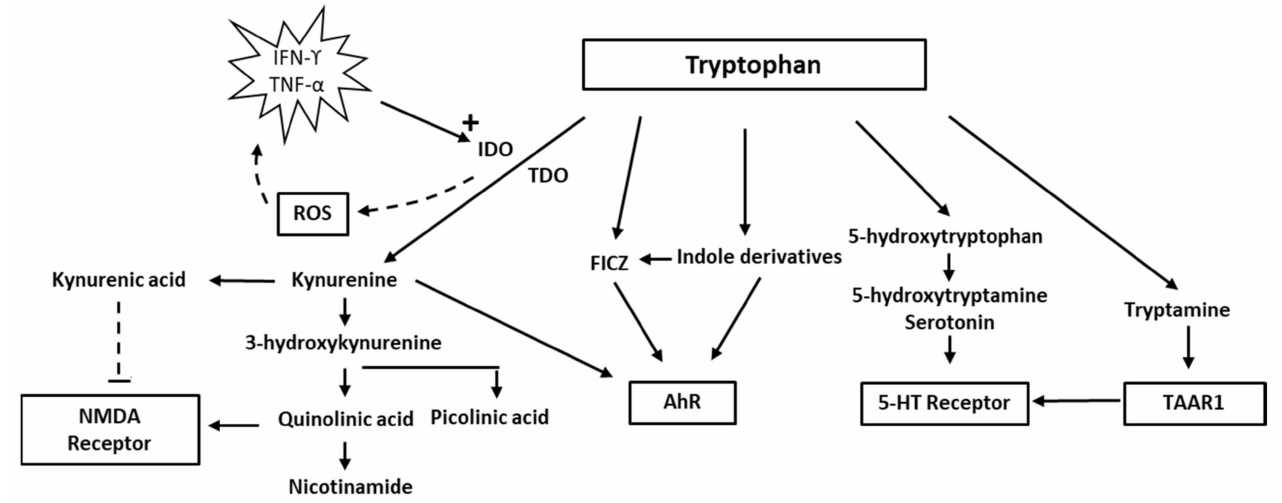
Figure 1. Pathways of tryptophan